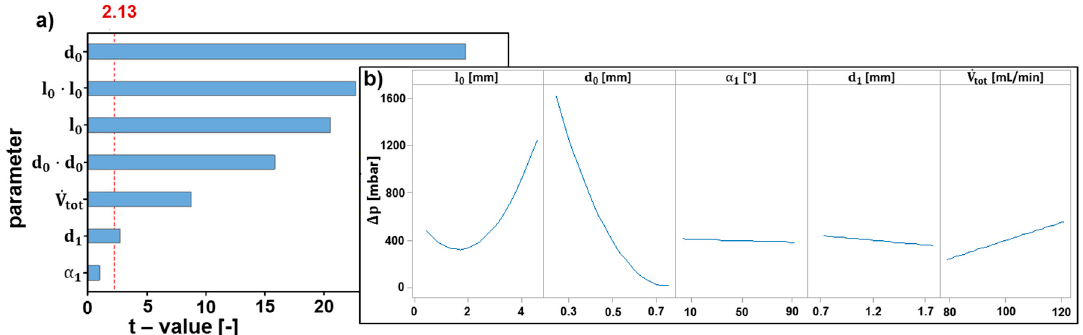
Figure 19. Final Pareto chart of effects ( a ) for pressure drop after exclusion of non-significant parameters and corresponding main effects diagram ( b ).